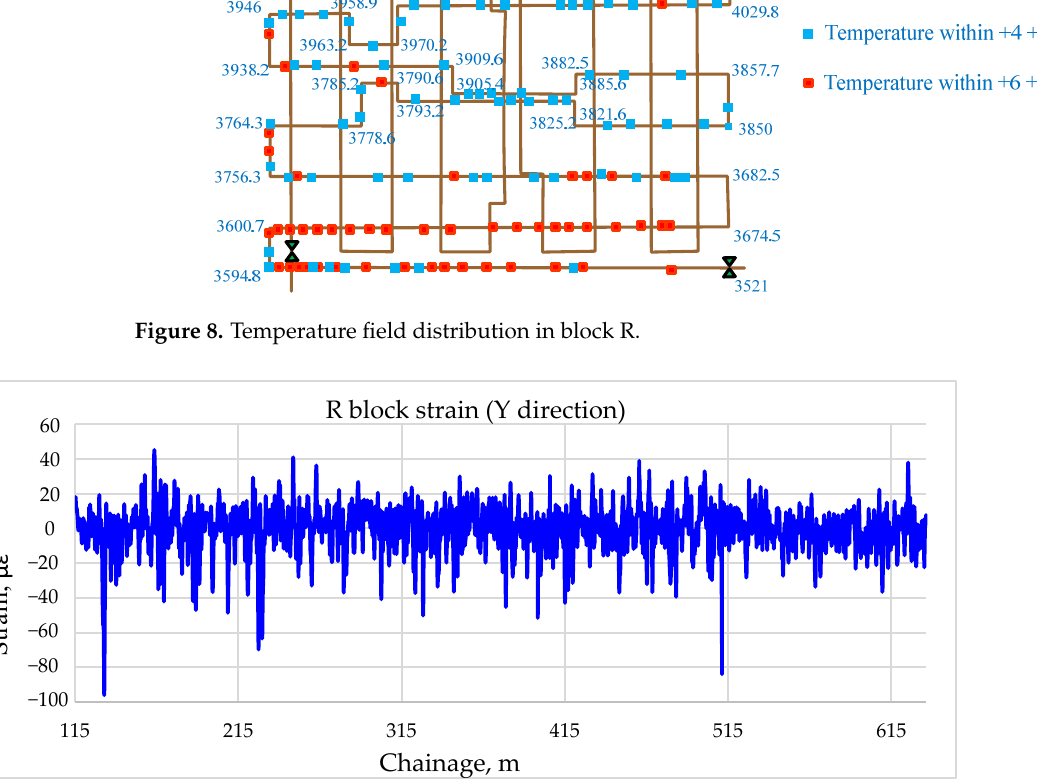
Figure 8. Temperature field distribution in block R.